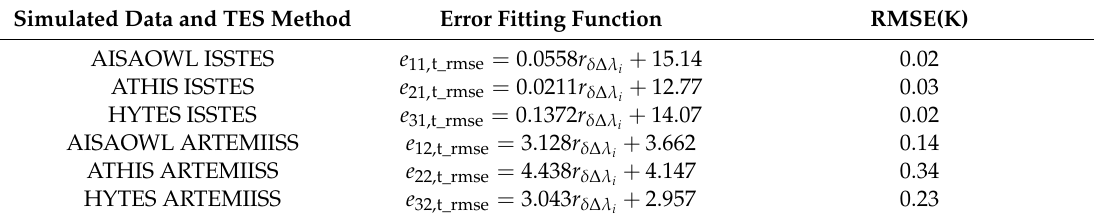
Table 5. The LST error fitting function about FWHM change ratio.